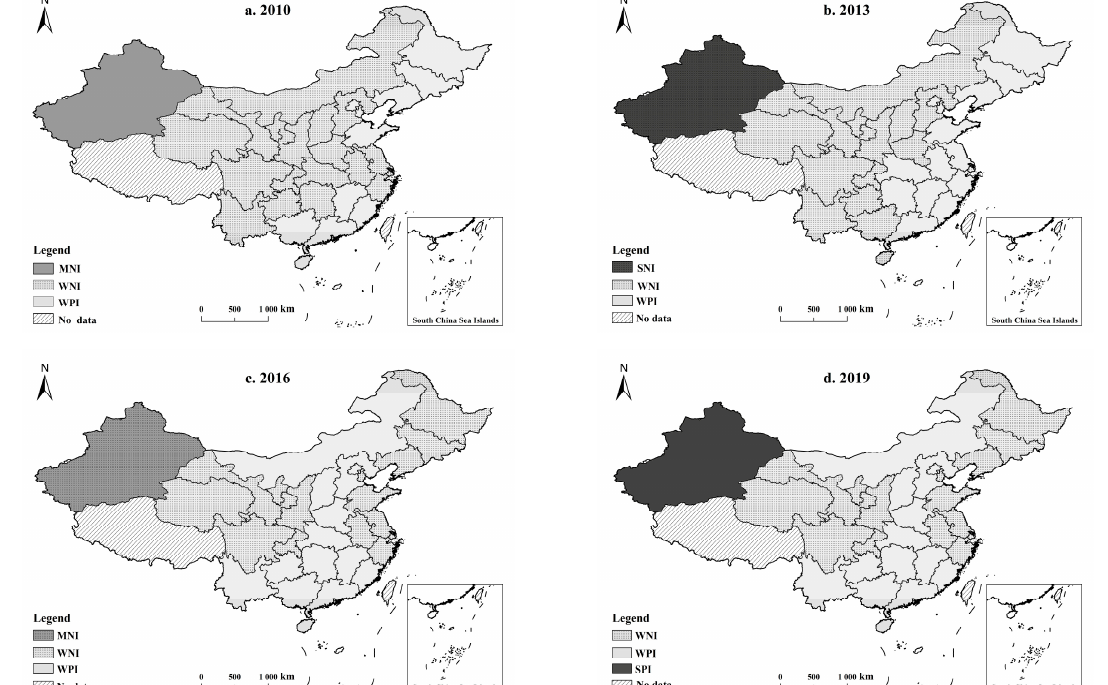
Figure 4. Spatial distribution of the regression coefficients of urbanization: ( a ) Spatial distribution of the regression coefficients of urbanization in 2010; ( b ) Spatial distribution of the regression coefficients of urbanization in 2013; ( c ) Spatial distribution of the regression coefficients of urbanization in 2016; ( d ) Spatial distribution of the regression coefficients of urbanization in 2019.